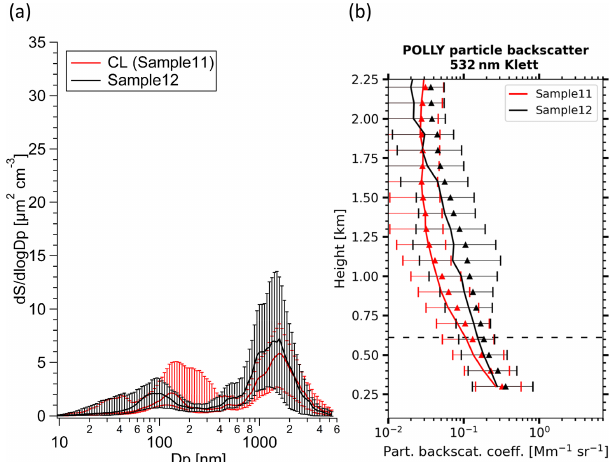
Figure 9. (a) Particle surface area size distribution for samples 11 (red) and 12 (black). (b) Vertical profile of particle backscatter co- efficient during samples 11 (red) and 12 (black). The triangles show the mean values, and the dashed line shows the height of the Cerro Mirador station. The solid lines in both panels show the median value, and error bars show the 25th to 75th